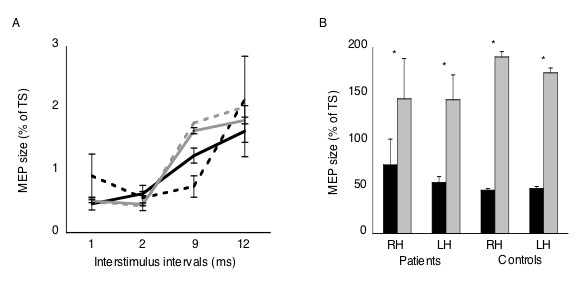
Intracortical inhibition and facilitation evoked by paired-pulse TMS. (A) The changes in MEP sizes of the contralateral FDI at the different interstimulus intervals. Black and gray lines show the percentage of MEP sizes for the patients and control groups, respectively. Continuous and dashed lines illustrate MEP amplitudes for the left and right hemisphere, respectively. (B) Size of MEPs for the short and long interstimulus intervals for each hemisphere and group. Black and gray columns show the percentage of MEP sizes for the short and long interstimulus intervals, respectively. RH: right hemisphere; LH: left hemisphere.